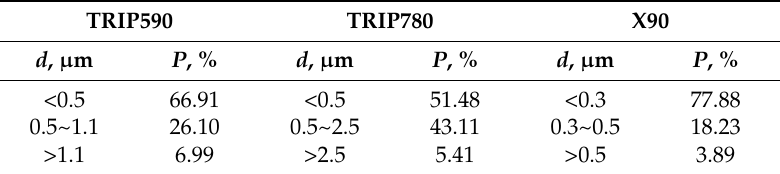
Table 4. The proportion of retained austenite ( P ) with different grain sizes ( d ).